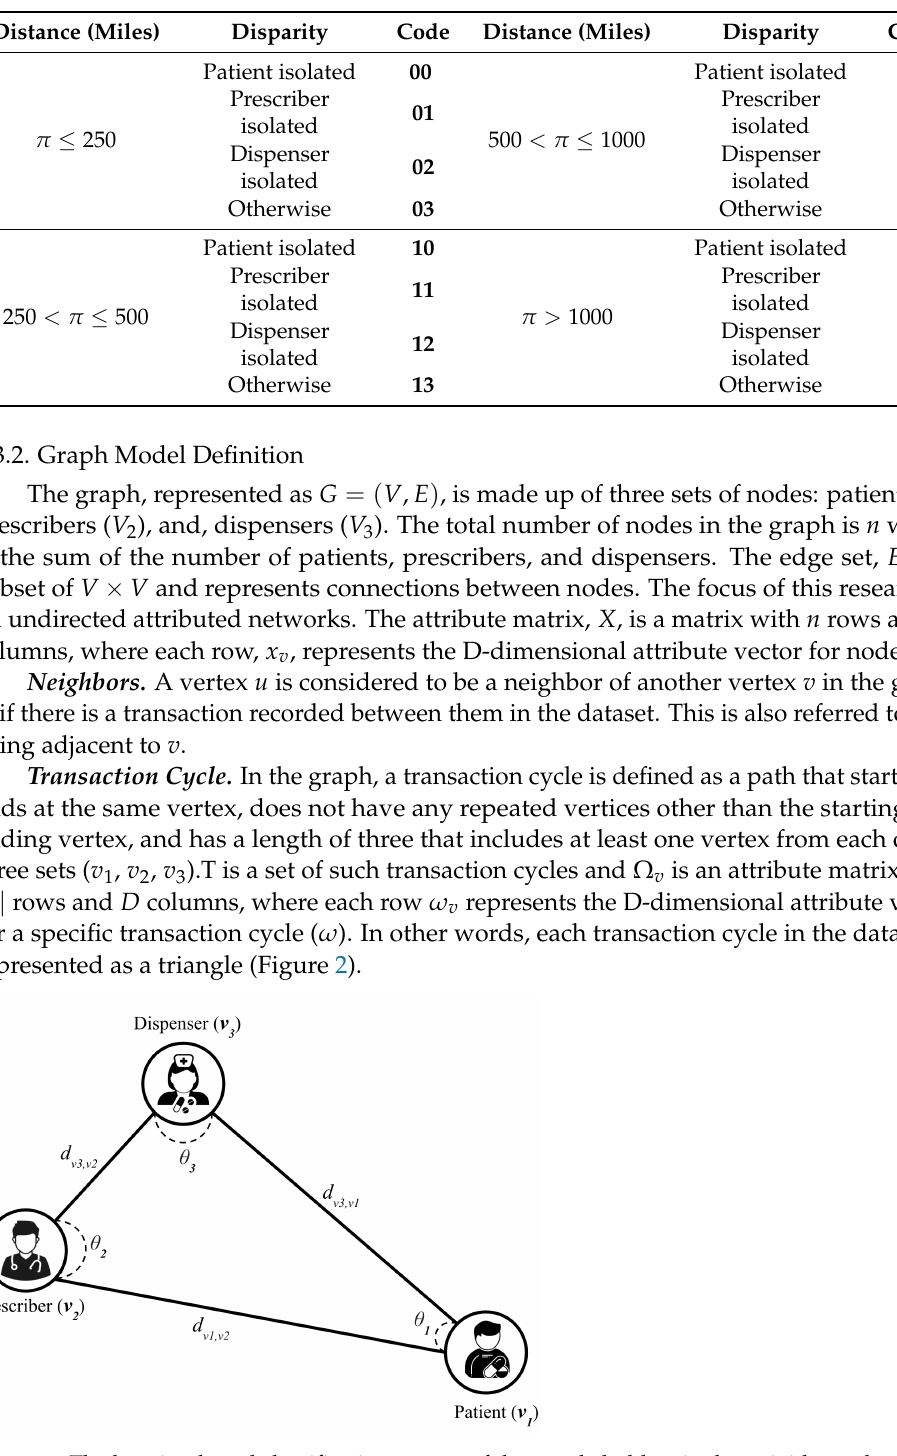
Figure 2. The location-based classification system of three stakeholders in the opioid supply